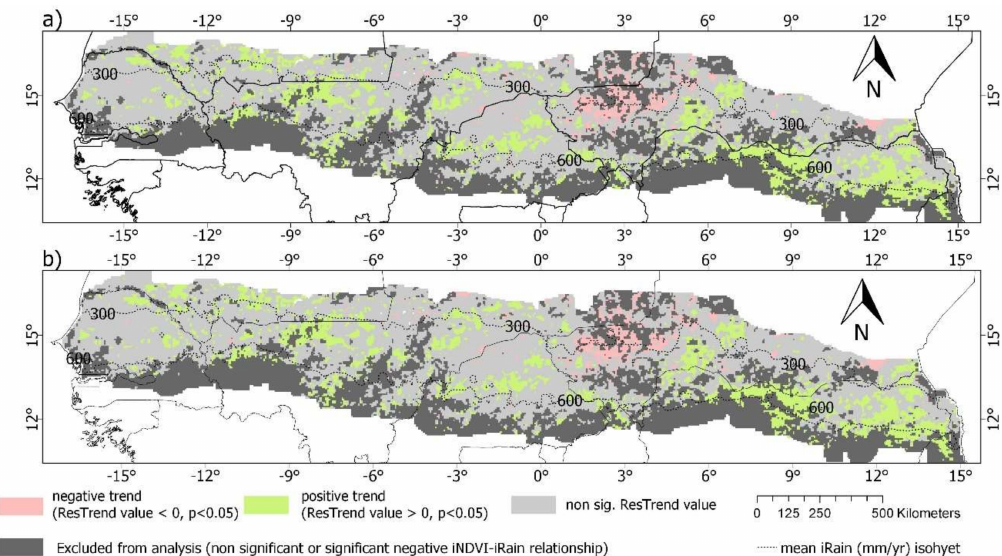
Figure 6. Nonspecific vegetation trends (1982–2013) in the WASS region based on trends in the residuals of i NDVI– i Rain relationships: ( a ) trends based on residuals from linear model only, ( b ) trends based on residuals of the best model determined by AIC (linear or log-linear). The similarity between both figures shows that choosing the best model had no discernible effect on the sign (+/ − ) and significance ( p -value < 0.05) of ResTrend values, consistent with was found during previous watershed scale analysis